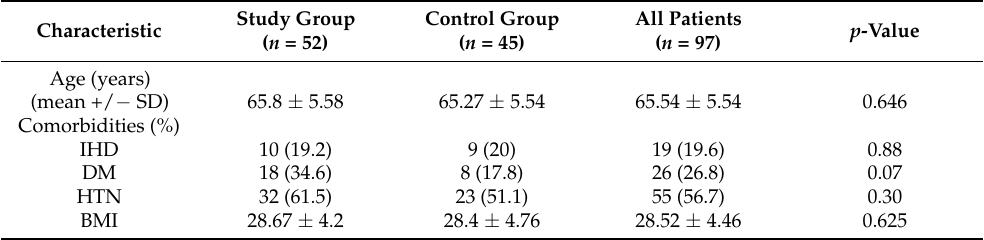
Table 1. Patient characteristics.